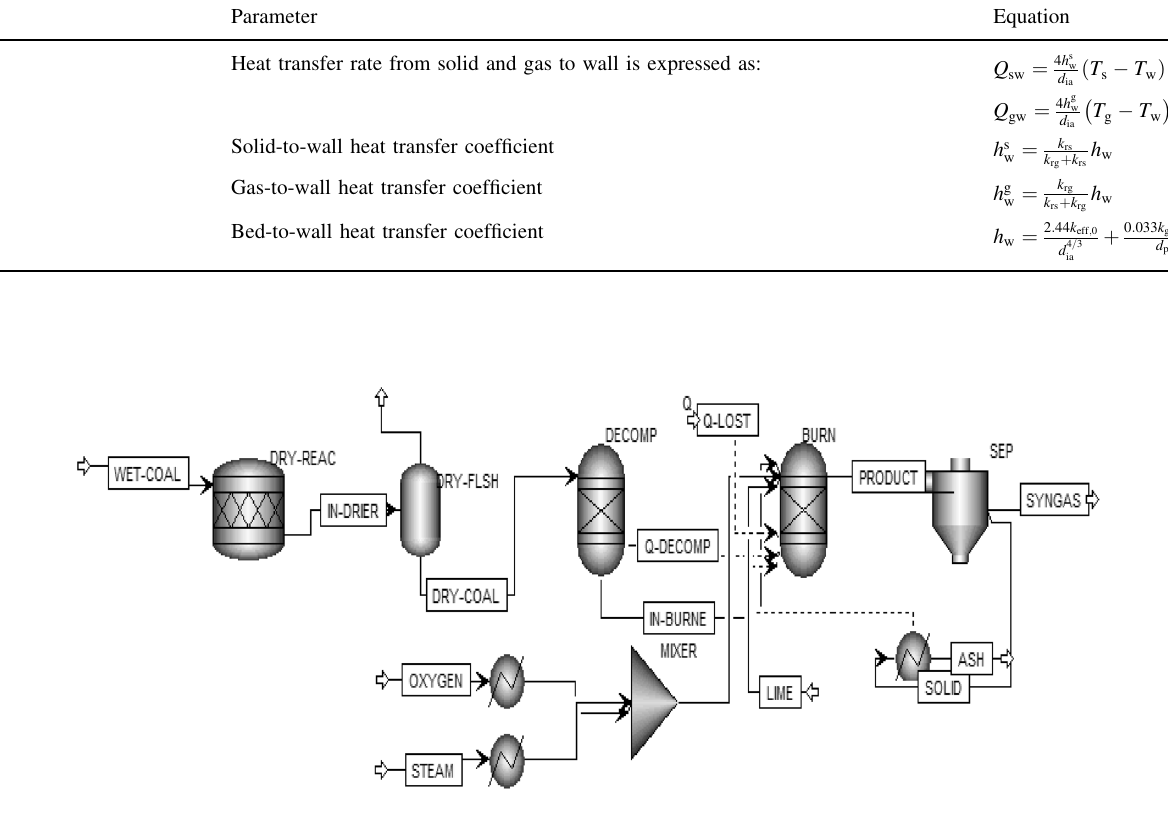
Fig. 3 Schematic diagram of fixed-bed gasification